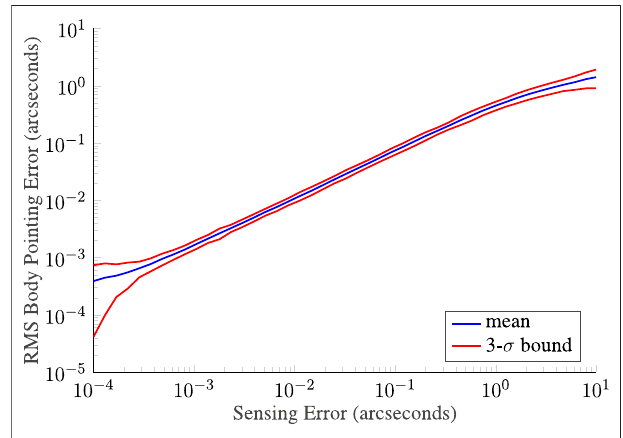
FIGURE 8 | Body-pointing RMS error as it relates to the sensing error (whether photon or detector limited). Data are from 1,000 Monte-Carlo trials with full environmental disturbance torques. Each point on these curves corresponds to a full simulation analogous to that shown in Figure 7